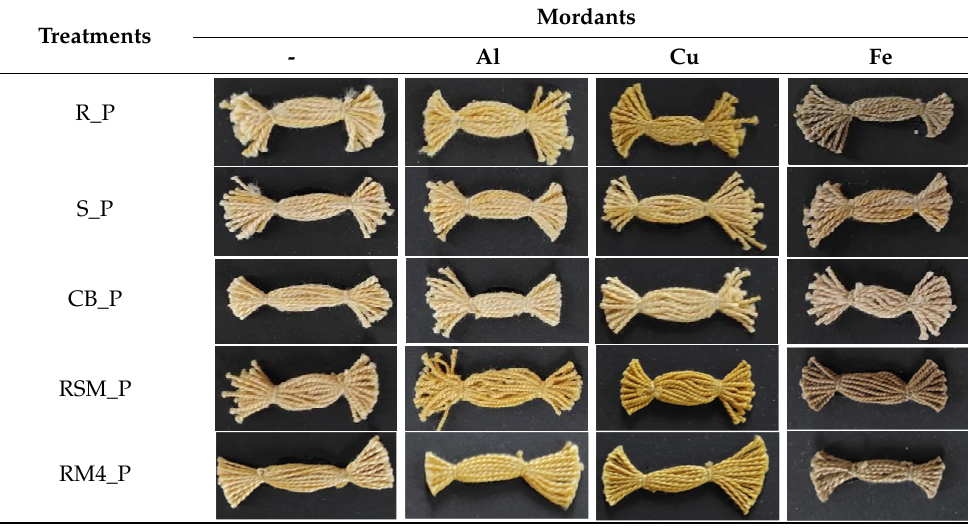
Table 7. Colour fastness to washing after 1st and 5th cycles of washing of cotton yarns dyed with onion